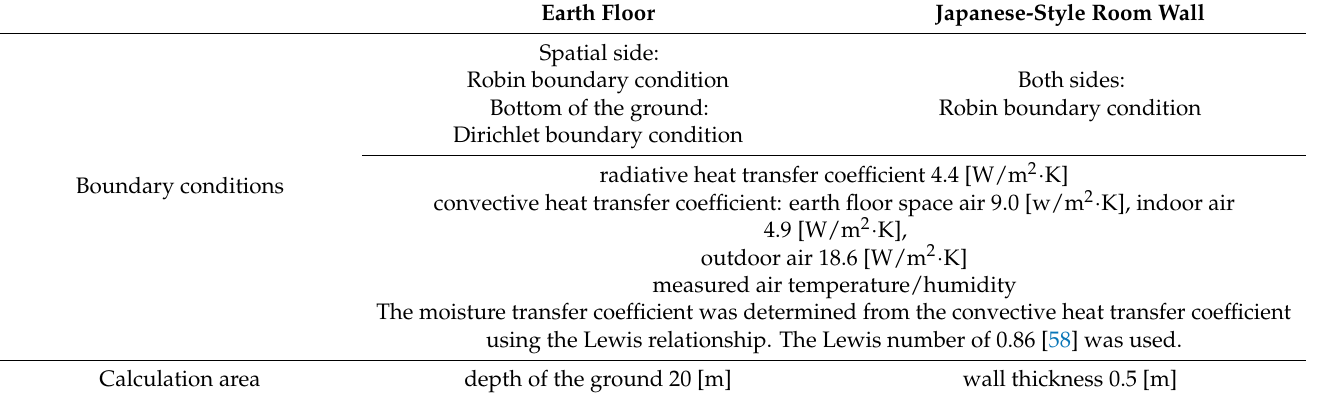
Table A1. Cont. Earth